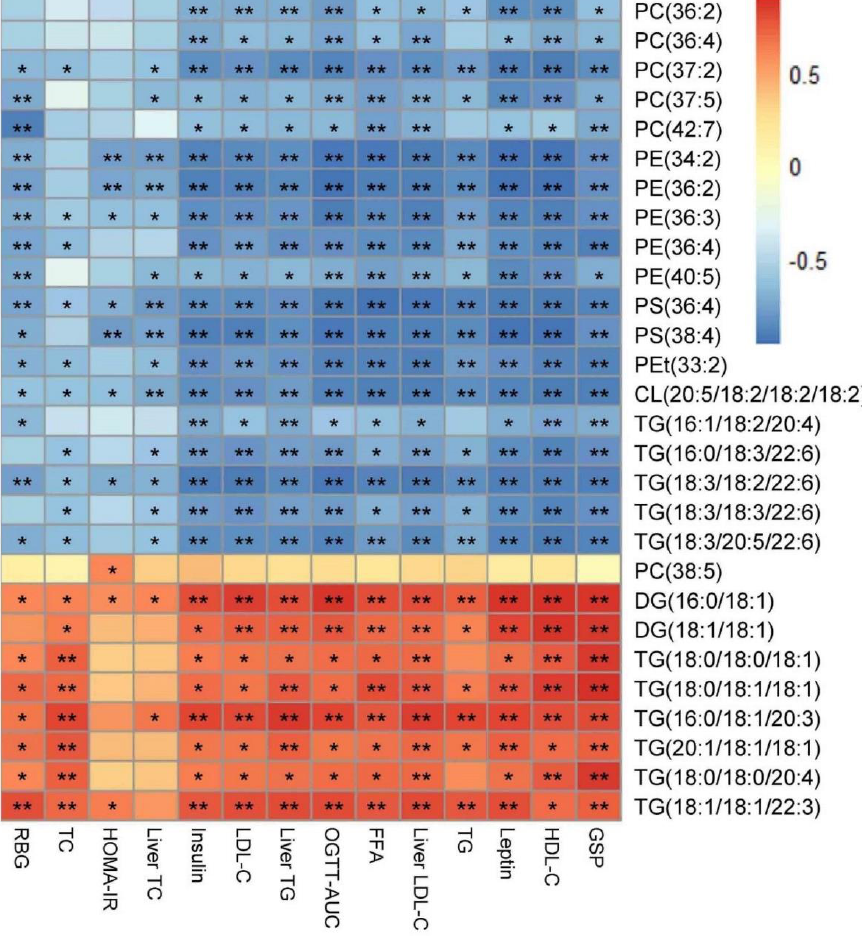
Figure 8. Spearman’s correlation between lipid species and obesity related indexes. Significant correlations are indicated by * p < 0.05, ** p < 0.01. RBG, random blood glucose; HOMA − IR, homeostatic model assessment of insulin resistance; OGTT-AUC, area under curve of oral glucose tolerance test; GSP, glycated serum protein level. The RBG, HOMA − IR, OGTT − AUC, GSP, insulin, and leptin levels are showed in Figure S5 in the Supplementary Materials.